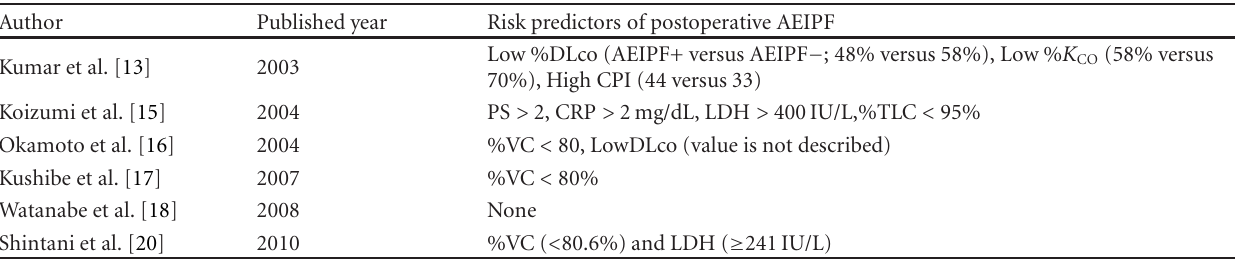
Table 3: The risk predictors of the postoperative acute